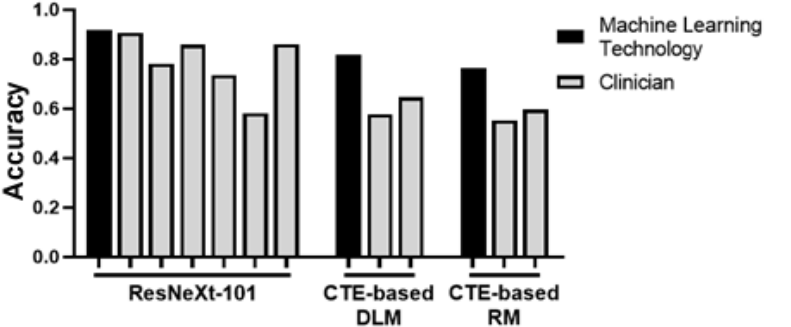
Figure 1. Machine learning- and clinician-derived data [38,62,63] were compiled into the depicted graph to demonstrate accuracy as measured by either percent or AUC. In each case, machine learning algorithms performed on par or better. This is anticipated to reduce human error in accurate diagnosis (original graph).